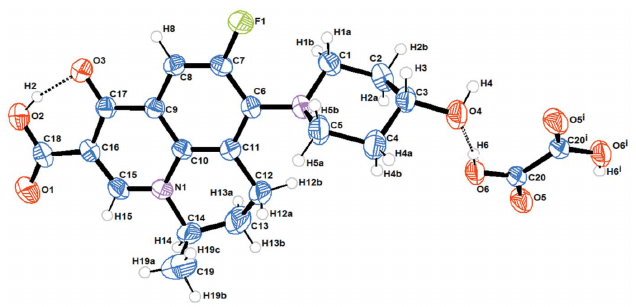
Figure 1 A perspective view of the title compound with labeling scheme and 50%